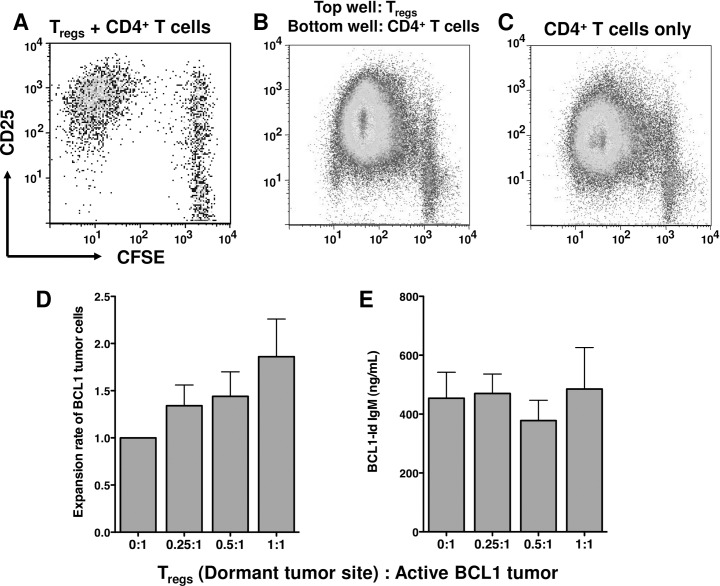
Tregs suppress CD4+ T cell proliferation by cell contact but do not suppress BCL1 tumor cells.(A) Tregs from mice harboring dormant BCL1 tumor cells were cultured in equal numbers with CFSE-labeled CD4+ T cells. (B) Tregs were plated onto trans-well inserts and placed in wells containing CFSE-labeled CD4+ T cells in an equal ratio. (C) CFSE-labeled CD4+ T cells were assessed for proliferation in the absence of Tregs. Plots are representative of 3 or more experiments yielding similar results. (D) Graded numbers of Tregs from mice with dormant BCL1 tumor cells were co-cultured with BCL1.3B3 tumor cells. Proliferation of BCL1.3B3 cells in the absence of Tregs (0:1) was considered to be the baseline values. Data represent the average of 3 experiments. E, BCL1-Id+ IgM secreted by BCL1.3B3 cells as measured by ELISA. Data represent the average of 4 experiments.